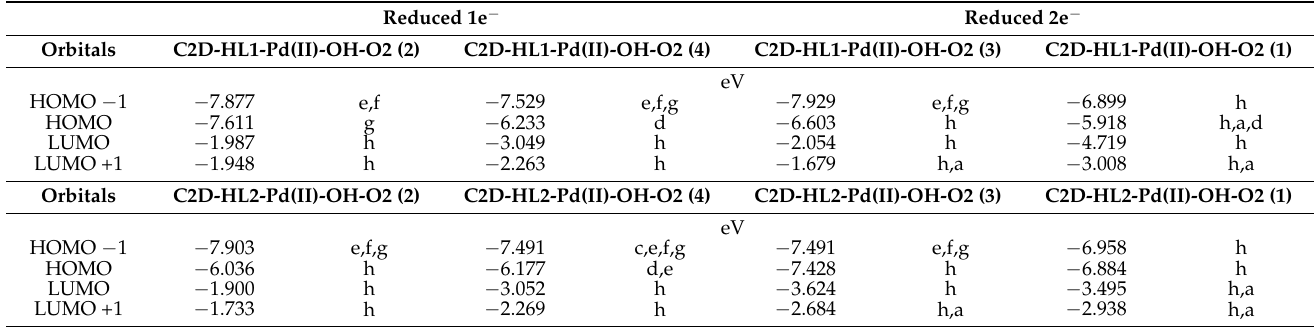
Table 2. Orbitals energies of Cat1 and Cat2 value in eV. Spatial location of orbital is assigned with letters a—pyrimidine anchorage site, b—spacer group, c—macrocyle, d—pyridine, e—Palladium, f—hydroxyl anion, g—Oxygen, h—C2D carbon surface. Reduced 2e − species are calculated from reduced 1e − with single-point energy calculations. Alfa OM energies are reported in the case of unrestricted calculation. For a more detailed table, see Supporting